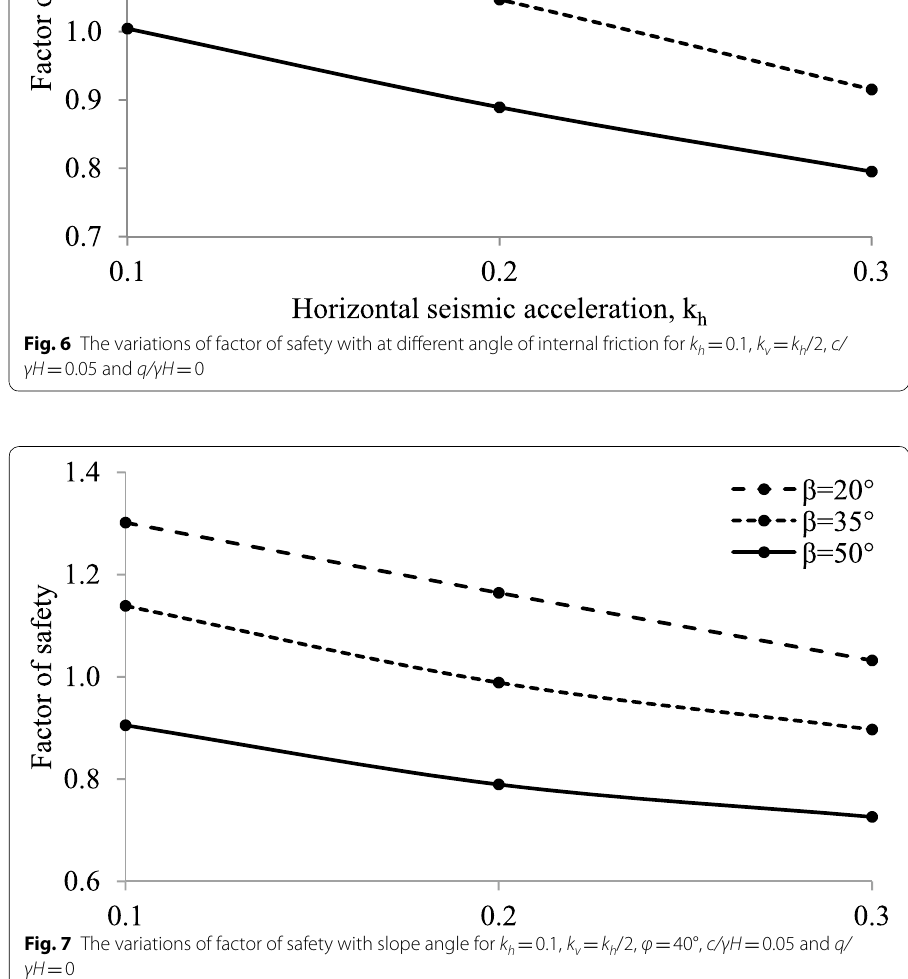
Fig. 7 The variations of factor of safety with slope angle for k h γH =